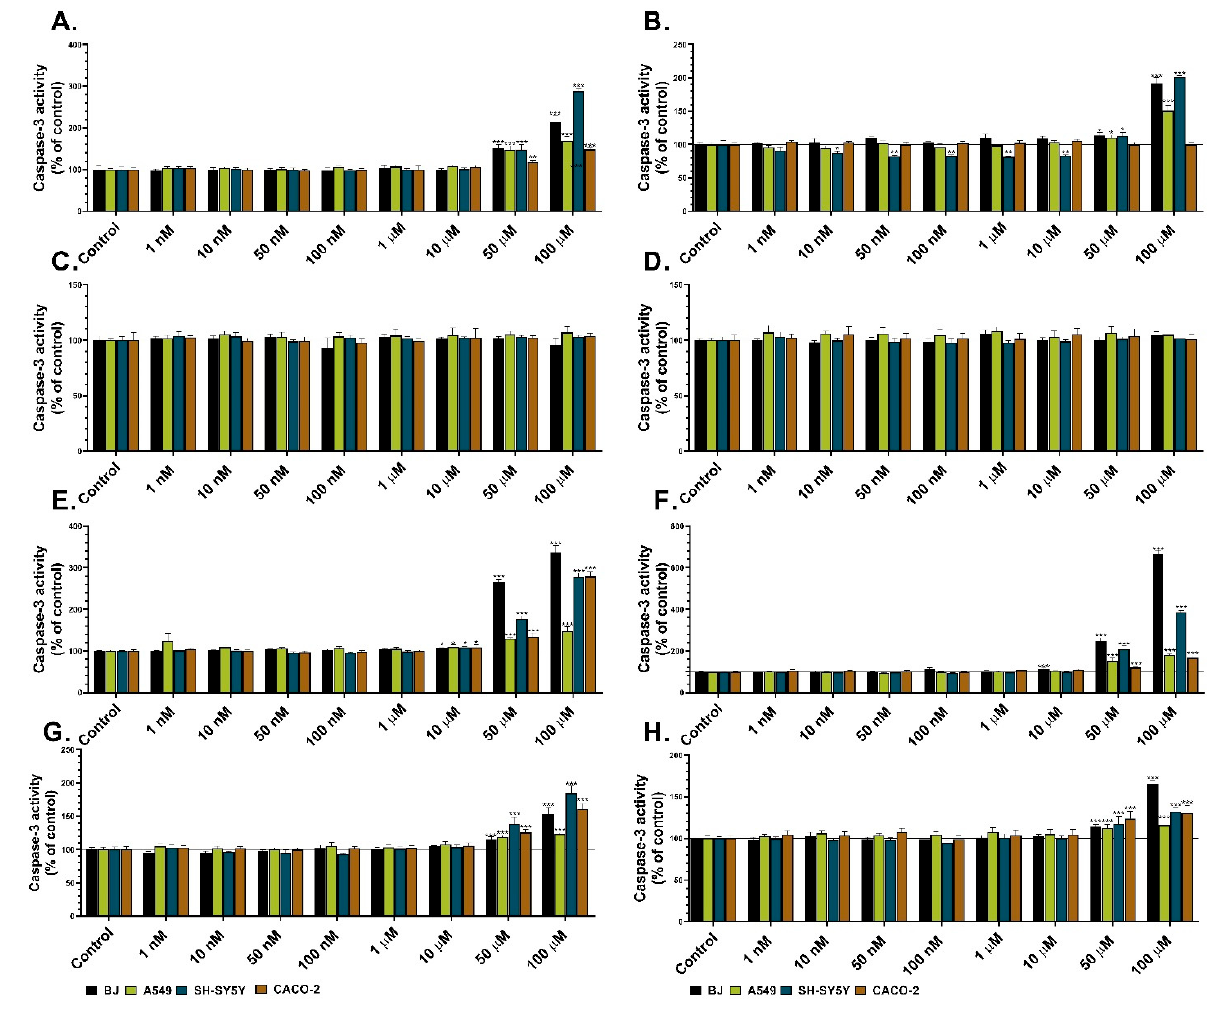
Figure 4. Caspase-3 activity in BJ, A549, SH-SY5Y, and CACO-2 cell lines after 24 h ( A , C , E , G ) and 48 h treatments ( B , D , F , H ) with Les-3166 ( A , B ), Les-5935 ( C , D ), Les-6009 ( E , F ), and Les-6166 ( G , H ). Mean values ( n = 6) with standard deviation (error bars) where *, **, and *** are statistically different from the respective (vehicle-treated) control at p < 0.05, p < 0.01, and p < 0.001, respectively (one-way ANOVA, Tukey’s test).